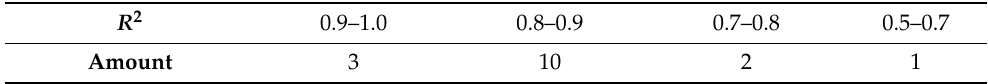
Table 2. The correlation coefficient of the measured and simulated